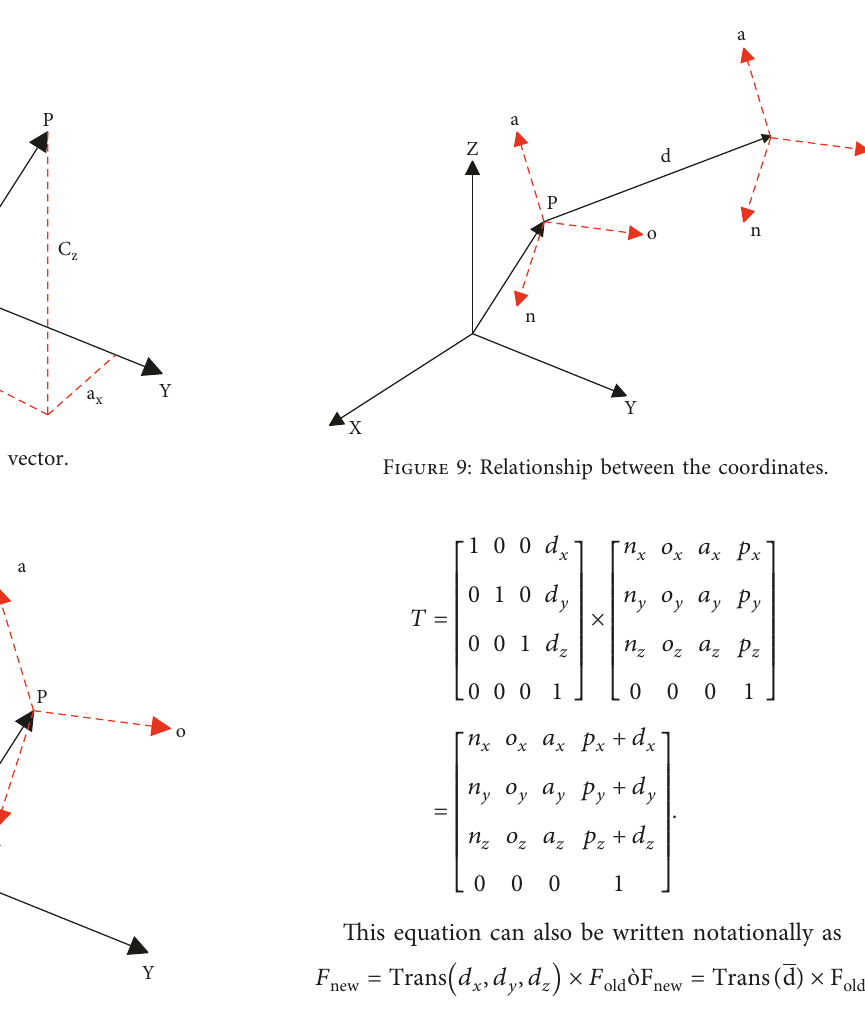
Figure 8: Relationship between the coordinates.